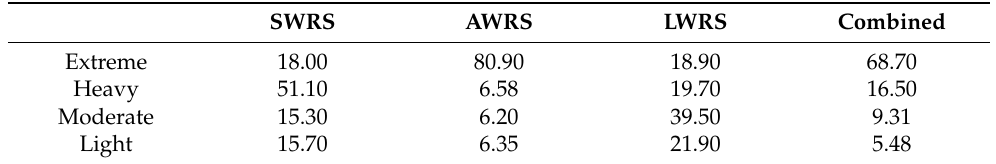
Table 6. Weather Conditions—Posterior probabilities for the isolated sensors and the combination of all